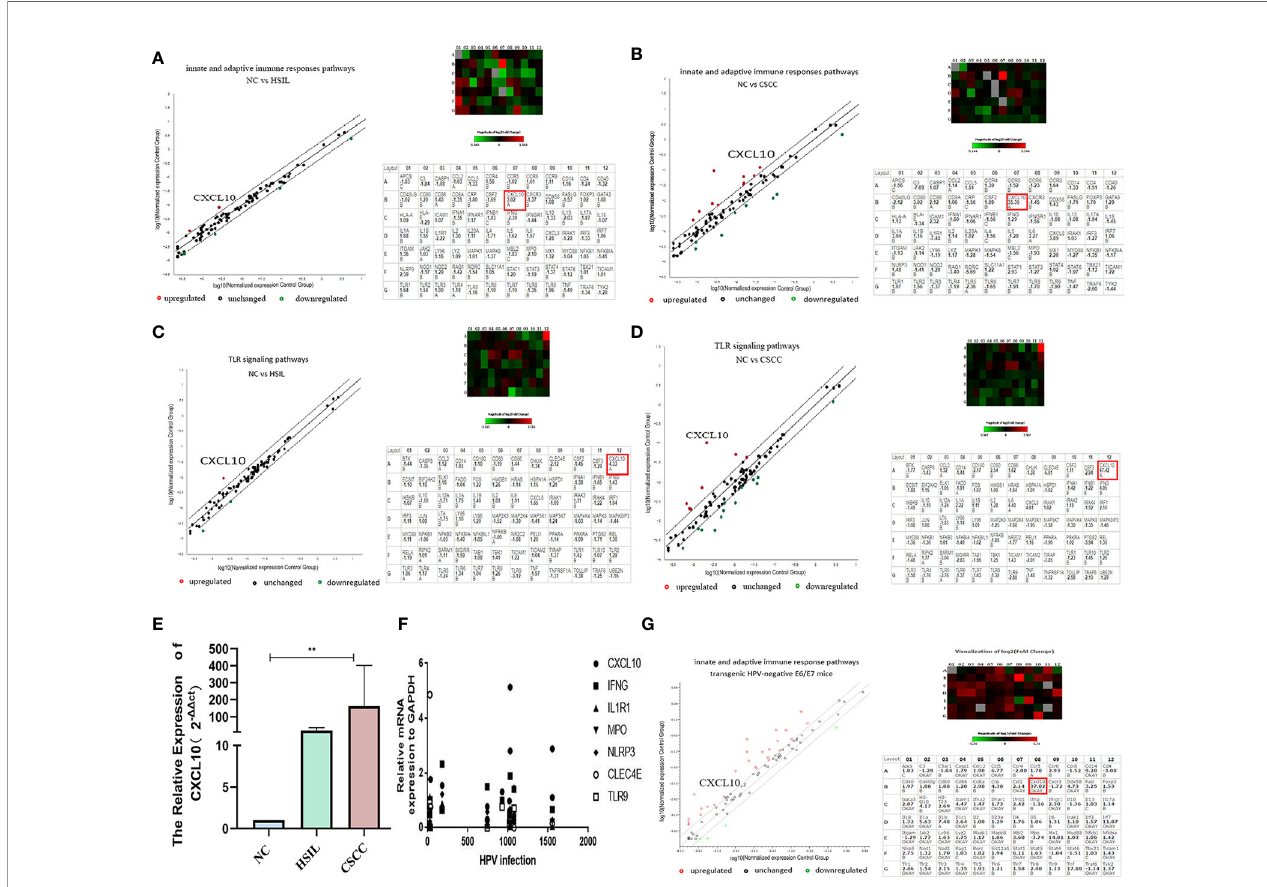
FIGURE 1 | Upregulated expression of CXCL10 in cervical tissues at both the HSIL and CSCC stage; (A, B) PCR array analysis of innate and adaptive immune response pathways Heat map showing differentially expressed genes in HSIL or CSCC and Human innate and adaptive immune response pathways gene table (PAHS-052Z) used in RT2 pro fi ler PCR array experiments; (C, D) PCR array analysis of the TLR signal transduction pathway (PAHS-018Z); (E) The relative expression of CXCL10 in different group by qRT-PCR showed that the mRNA expression of CXCL10 was the highest in CSCC group; (F) Correlation analysis between the viral load of HPV infection and the expression of key gene in innate and adaptive immune response pathway including CXCL10; (G) Results of PCR array analysis in the innate and adaptive immune response pathways in HPV16 E6/E7 transgenic mice revealed by scatter and cluster diagrams (PAMM-052Z). *P < 0.05, **P < 0.01, ***P<0.001 and ****P < 0.0001, as determined by Student ’ s